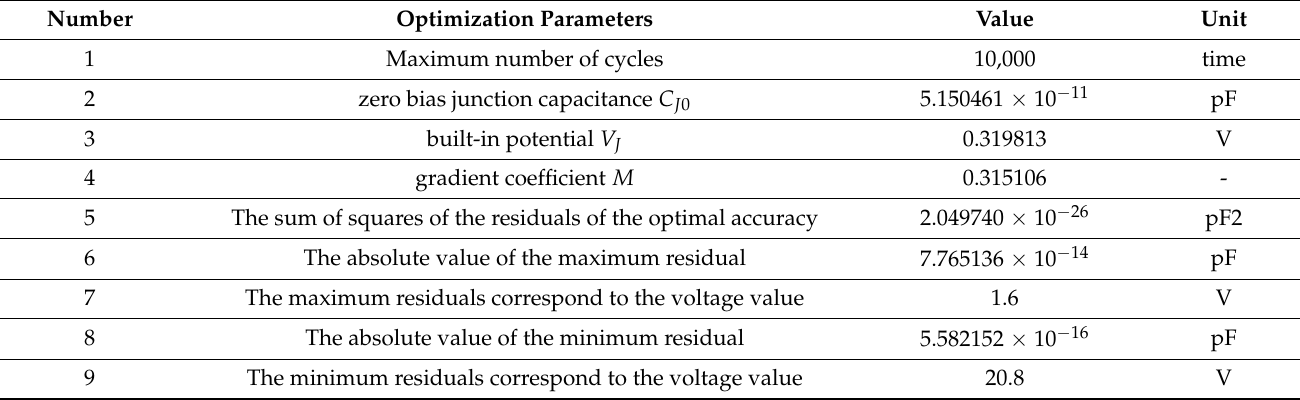
Table 3. Parameter fitting result of the C-V characteristic model of the